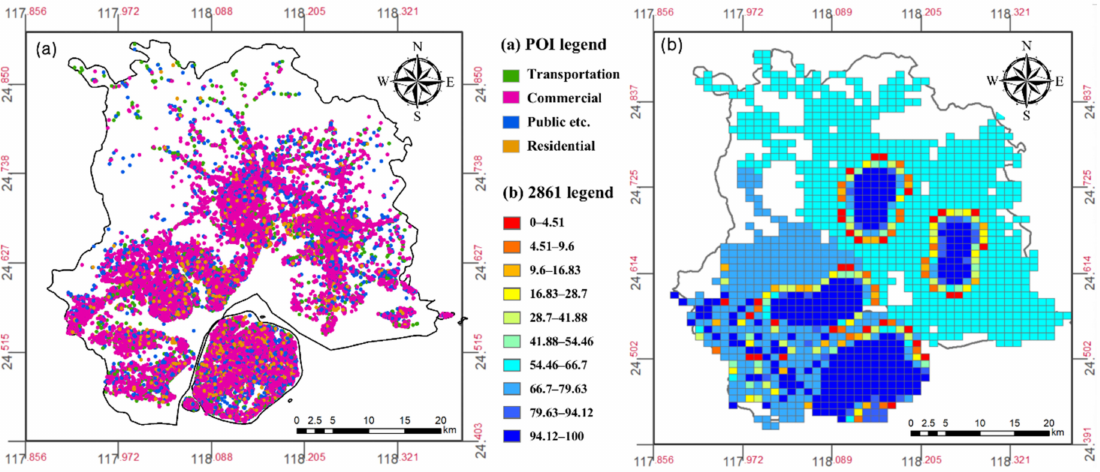
Figure 2. POI and 2861 index data of Xiamen. ( a ) POI data; and ( b ) 2861 shopping convenience